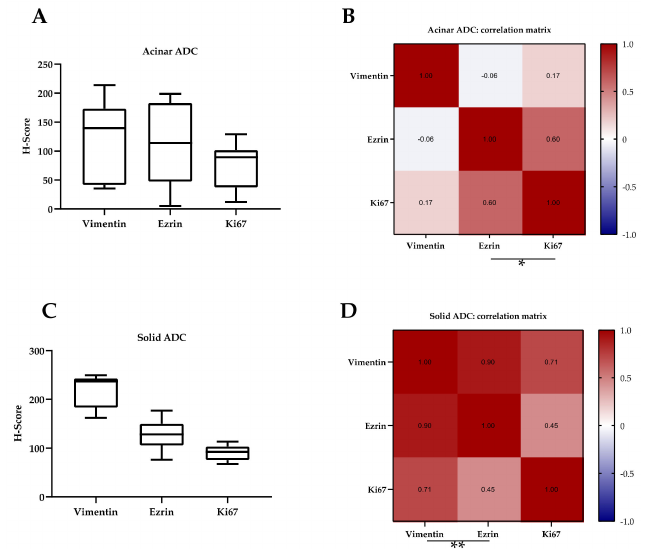
Figure 6. H-scores of vimentin, ezrin, and Ki67 protein expression in ADC. ( A ) Comparison of H- scores from the indicated proteins in acinar ADC patients (LF01, LF19, and LF20). The graph shows box and whisker plots for the H-scores of every protein. ( B ) Correlation matrix obtained by applying Spearman’s rank correlation coefficient to all of the H-scores ( n = 12 per protein) of acinar ADC patients by pairs of proteins. ( C ) Comparison of H-scores from the indicated proteins in differentiated solid ADC patients (LF05, LF15). The graph shows box and whisker plots for the H-scores of every protein. ( D ) Correlation matrix obtained by applying Spearman’s rank correlation coefficient to all of the H-scores ( n = 12 per protein) of solid ADC patients by pairs of proteins. Coefficients are shown inside every comparison square. *: p -value < 0.05; **: p -value < 0.005; ADC: adenocarcinoma.